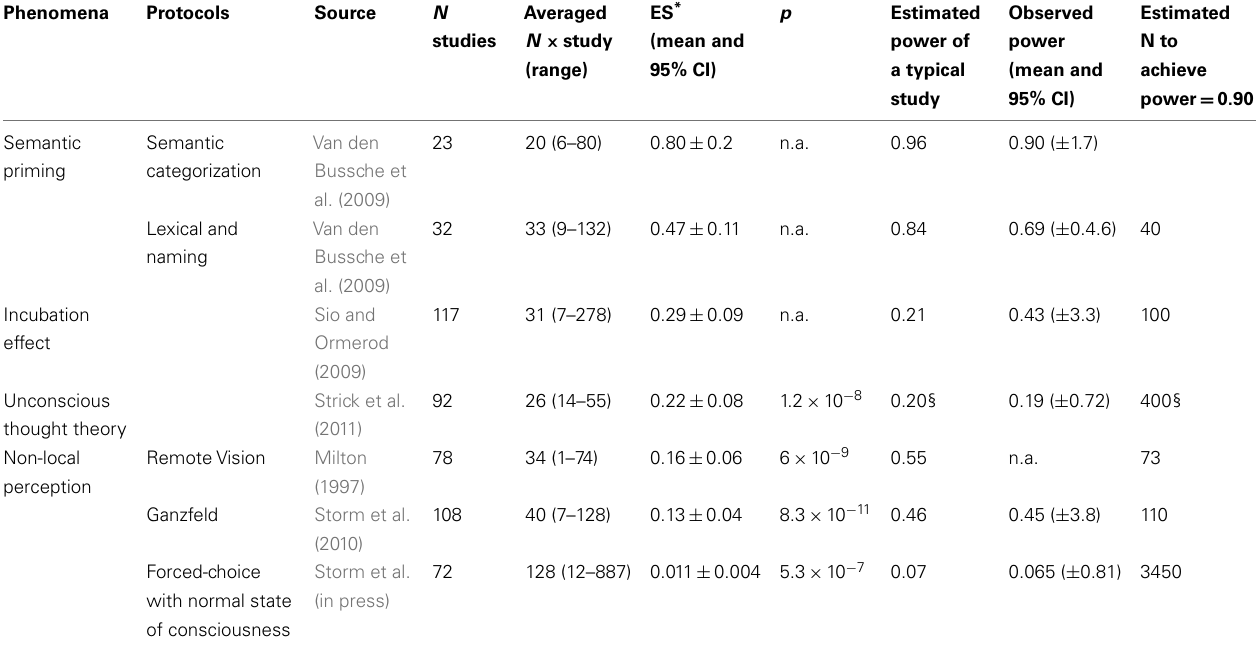
Table 1 | Descriptive statistics of the four meta-analyses, related to Unconscious Semantic Priming, Incubation effect, UTT, and NLP with the estimated power of a typical study, the mean and 95% CI power calculated from all studies included in the meta-analysis and the number of participants necessary to obtain a Power =